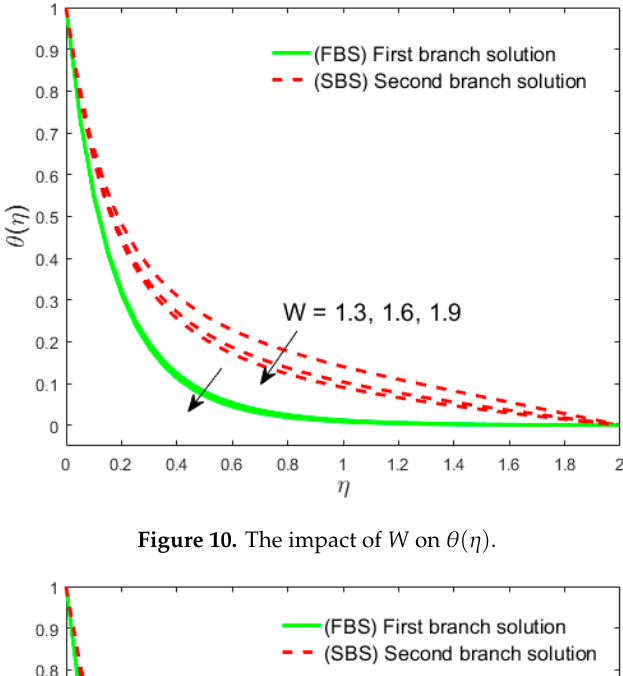
Figure 9. The impact of 1 S on